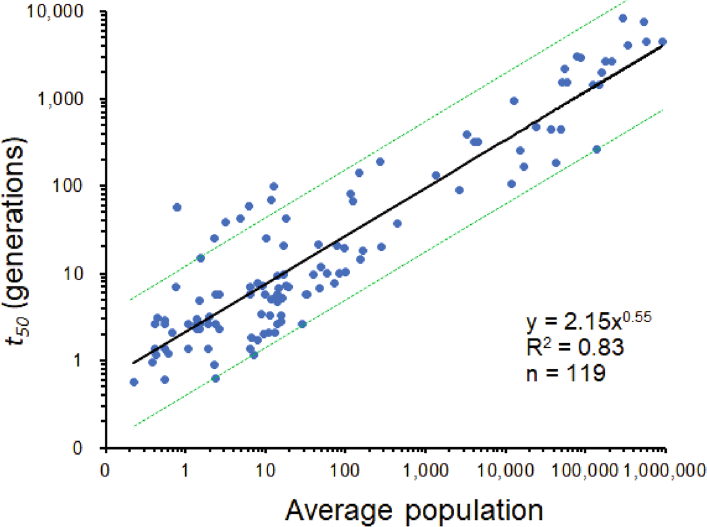
Figure 1. Relation between observed relaxation half-life ( t 5 0 ) and average population per species for mammal communities in habitat remnants at the time of isolation. Data are from nine studies spanning four continents presented in a large meta-analysis by Halley et al. 2016 25 . The regression line is shown in black and the dashed green lines are the 90% prediction intervals. Prediction intervals were calculated in R 57 . The regression analysis estimates both the parameters of Eq. (5) ( c = ln(2.15) and α = 0.55) and their standard errors (δ c = 0.134 and δ α =